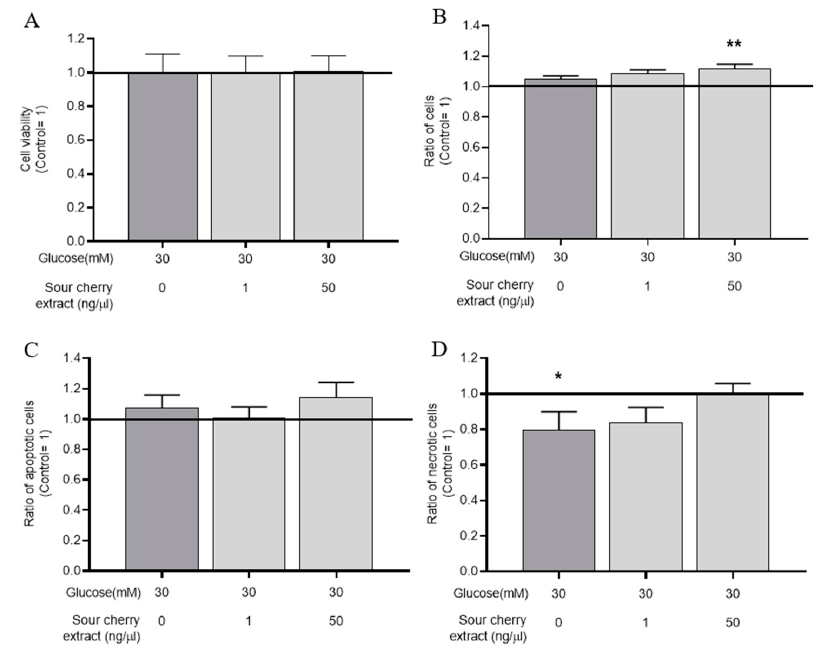
Figure 1. Combined use of anthocyanin-rich sour cherry extract and high glucose does not influence viability of human umbilical cord vein endothelial cells (HUVECs). Viability of HUVECs was monitored following48htreatmentby3-(4,5-dimethylthiazol-2-yl)-2,5diphenyltetrazoliumbromide(MTT)( A )and Nile Red ( B ) assays. Early necrotic and apoptotic processes of HUVECs were monitored following 48 h treatment by DilC1(5) ( C ) and SYTOX Green ( D ) assays. Results are expressed as percentage of untreated control (100%, solid line), with normoglycemia (5 mM) as mean ± SEM of four independent determinations. * and ** mark significant ( p < 0.05 and p < 0.01, respectively) di ff erences compared to the vehicle control